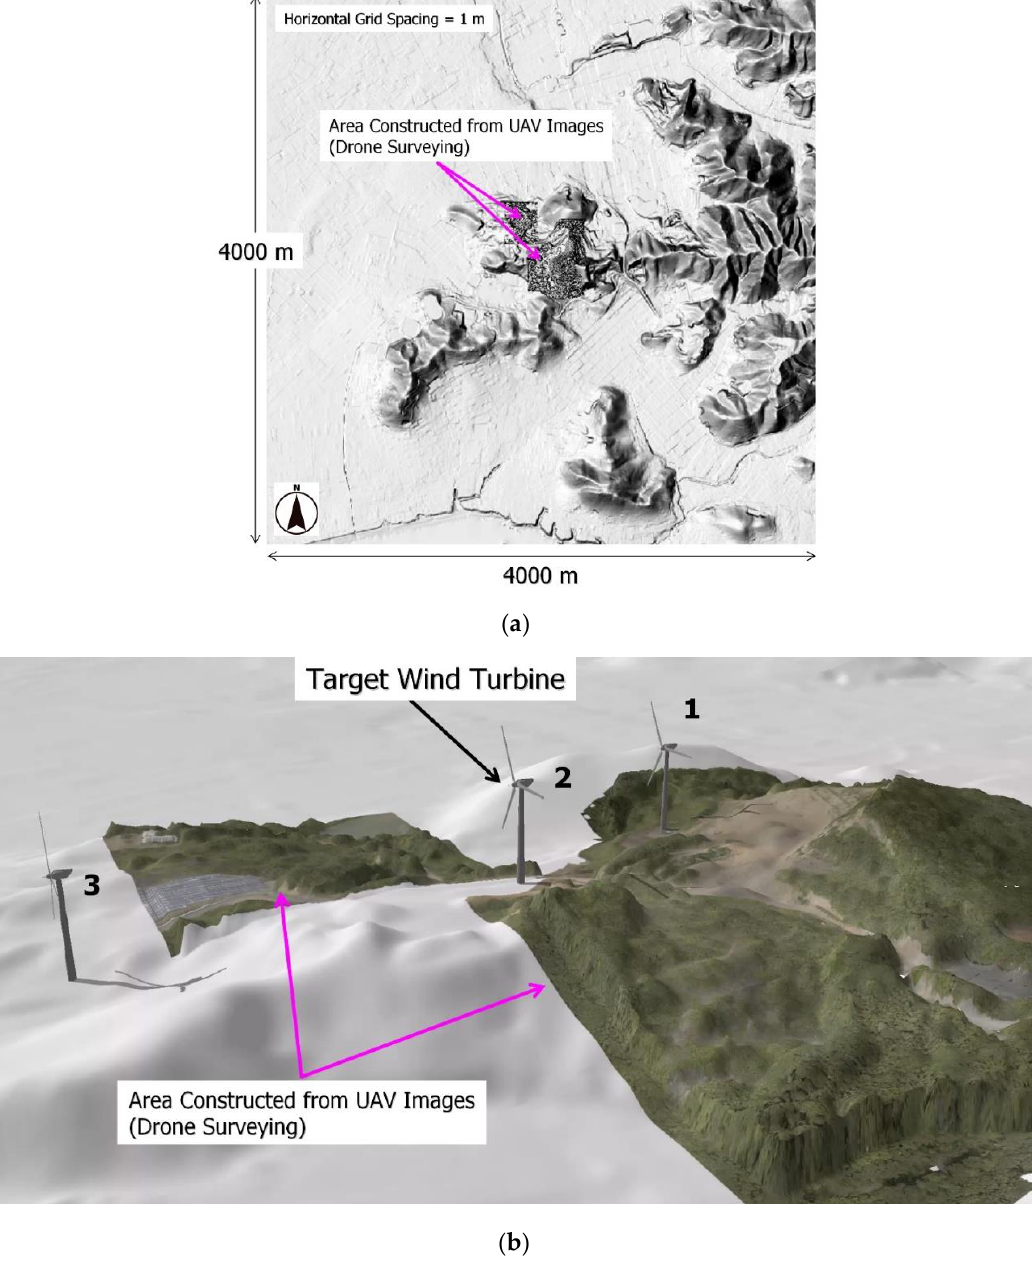
Figure 7. Three-dimensional topography model constructed by photographs taken from UAV: ( a ) top view and ( b ) bird’s -eye view with surface roughness.